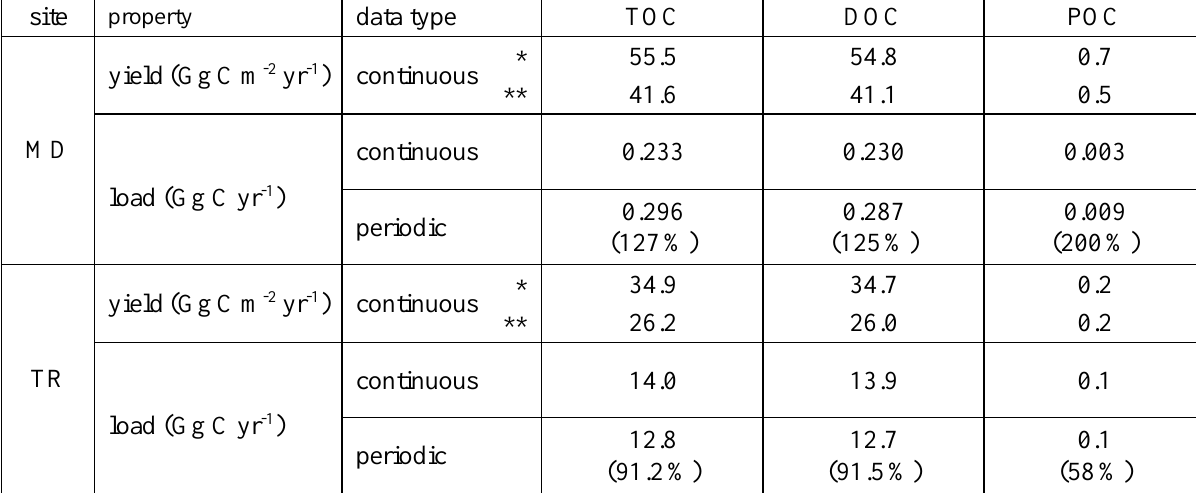
Table 3. Annual organic carbon (TOC, DOC and POC) yields and loads of Meranti Ditch (MD) and Turip River (TR) calculated using continuous and periodic stream stage data for the period 01 June 2012 to 31 May 2013. Yield = load / catchment area; * = upper estimate, ** = lower estimate (based on the lowest and highest estimates of catchment area obtained using the water balance method, see Table 2). For loads calculated from periodic data, values in parentheses indicate the results as percentages of the corresponding loads calculated using continuous